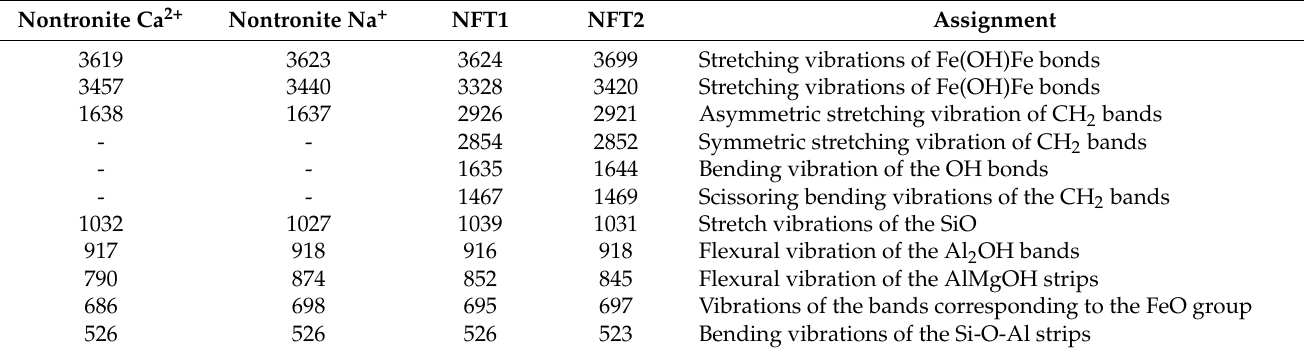
Table 4. Position (cm − 1 ) and assignments of the prominent bands of the modified and unmodified clays [25,26].